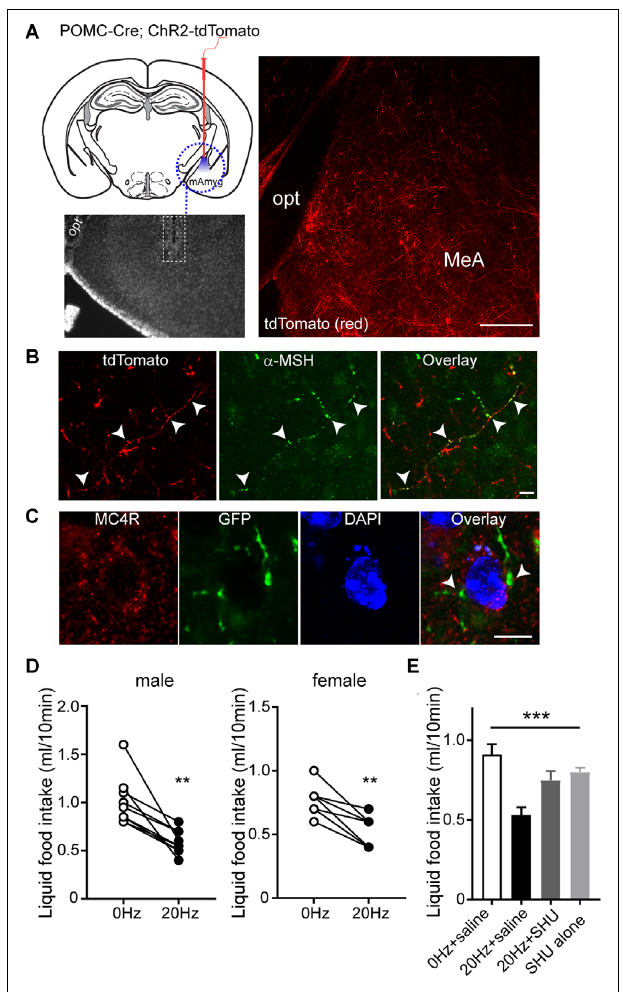
FIGURE 3 | Activating the ARC POMC → MeA projection leads to an acute reduction in food intake. (A) Schematic drawing of our experimental configurations. A mono fiber-optic cannula was implanted into the MeA of the POMC-Cre; ChR2-tdTomato mice (top panel). The bottom panel shows the implantation site. tdTomato-positive fibers were observed in the MeA of POMC-Cre; ChR2-tdTomato mice. Scale bar: 200 µ m. (B) Images of fluorescence confocal microscopy showing that tdTomato-positive fibers were positive for α -MSH in the MeA (white arrowheads). Scale bar: 10 µ m. (C) Images of fluorescence confocal microscopy showing that MC4R-positive cells receive POMC input from the ARC. GFP-positive fibers and axonal terminals made synaptic contacts with MC4R-positive cells (white arrowheads). Scale bar: 10 µ m. (D) Pooled data from nine male and seven female mice. Twenty hertz stimulation of the ARC POMC → MeA pathway significantly reduced liquid food intake (males, 1.0 ± 0.08 ml vs. 0.6 ± 0.04 ml, ** p < 0.01, n = 9 mice; females, 0.8 ± 0.05 ml vs. 0.5 ± 0.05 ml, ** p < 0.01, n = 7 mice). (E) Plot showing blockade of the effect of optogenetic stimulation of the ARC POMC → MeA pathway by the MC4R antagonist SHU9119 [1 mg/kg, n = 5 mice, SHU9119 alone, n = 8 mice, Treatment (between groups), F (3,9) = 10.3, *** p < 0.001, 0 Hz + saline vs. 20 Hz + saline, p < 0.001, 20 Hz + saline vs. 20 Hz + SHU9119, p < 0.05, 20 Hz + saline vs. SHU9119 alone, p <